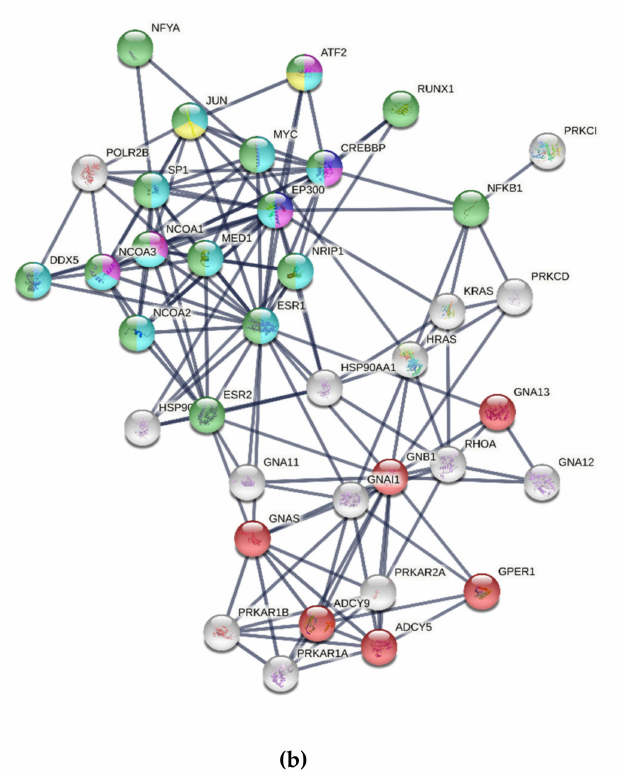
Figure 5. Protein–protein interaction networks for transcripts identified in the inner perivitelline layer, involved in: ( a ) eIF2 signaling, and ( b ) estrogen receptor signaling, according to an analysis by the STRING online database (version 11.0). The line indicates the strength of the data at the highest score (0.9). ( a ) Functional enrichments in eIF2 signaling, red: translation initiation factor activity, dark blue: structural constituent of ribosome, purple: GDP binding, green: protein serine/threonine phosphatase activity, light blue: GTP-binding, and yellow: kinase; ( b ) Functional enrichment in estrogen receptor signaling. Red: adenylate cyclase-activating G protein-coupled receptor signaling, dark blue: regulation of transcription from RNA polymerase II promoter, purple: histone acetyltransferase activity, light blue: DNA-binding transcription factor binding, yellow: AP-1 transcription factor, and green: transcription regulation. Description of gene/protein symbols are presented in the Supplementary Materials, Tables S1 and